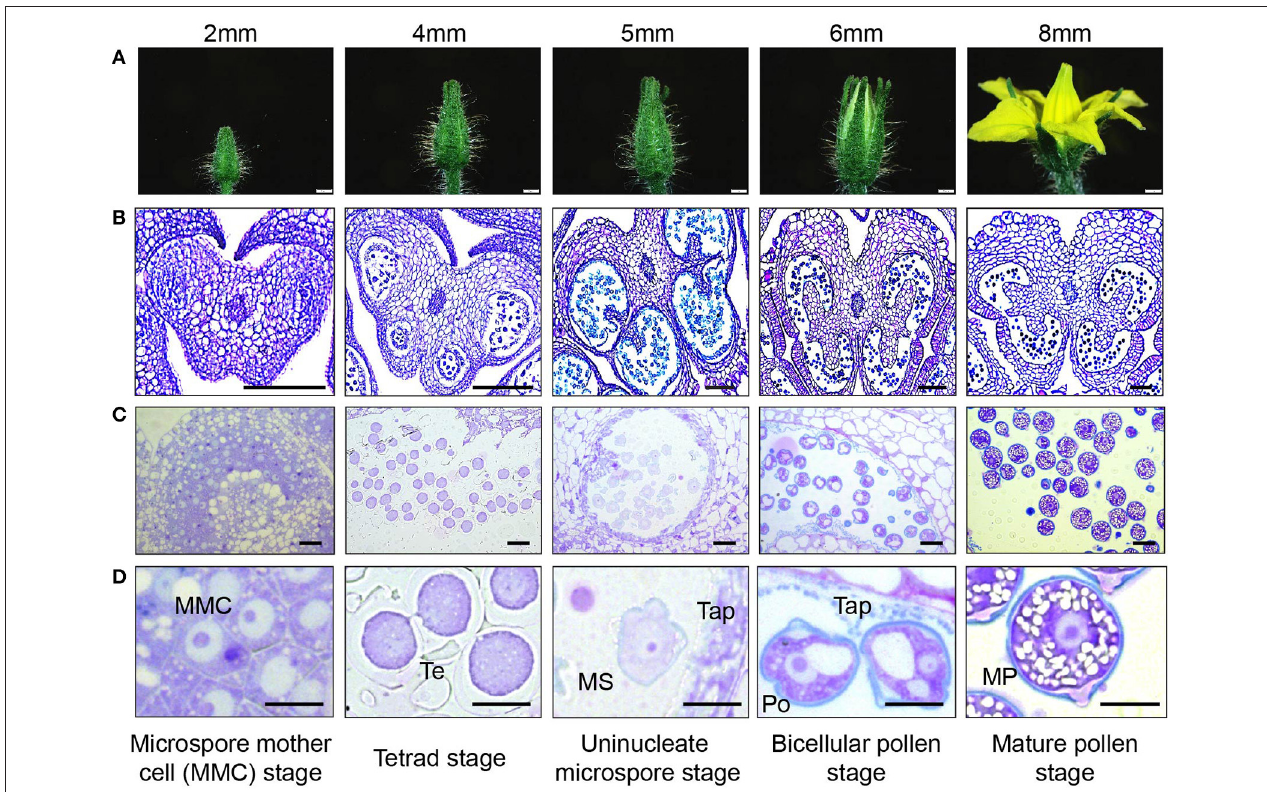
FIGURE 2 | Tomato pollen development staging. (A) photographic series of floral development in tomato, with bud length as a marker for each stage in pollen development inside the anther. Bud lengths, 2mm (microspore mother cell stage), 4mm (tetrad stage), 5mm (uninucleate microspore stage), 6mm (bicellular pollen stage), and 8mm (mature pollen stage). (B) Micrographs of paraffin-embedded 8- µ m-thick anther cross sections, stained with toluidine blue. (C) Micrographs of LR White embedded 500-nm-thick anther cross sections, also stained with toluidine blue. (D) Developing pollen grain at higher magnification, close-up of individual cells. MMC, microspore mother cell; Te, tetrad; MS, microspore; Tap, tapetum; Po, pollen; MP, mature pollen. Scale bars 1mm in (A) , 100 µ m in (B) , 20 µ m in (C) , and 10 µ m in (D) .